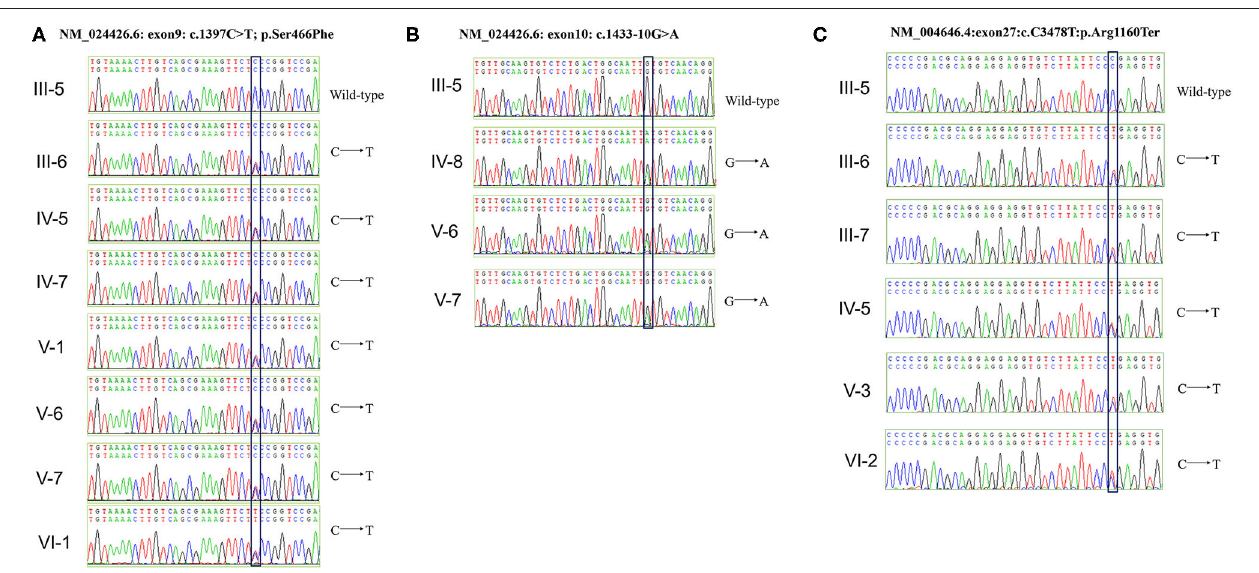
FIGURE 3 | Verification of WT1 and NPHS1 variants by Sanger sequencing. (A) The c.1397C > T; p.Ser466Phe mutation was verified in seven family members (III-6, IV-5, IV-7, IV-8, V-1, V-6, V-7, and VI-1). (B) The c.1433-10G > A mutation was verified in three family members (IV-8, V-6, and V-7). (C) The c.3478C > T; p.Arg1160Ter mutation was verified in five family members (III-6, III-7, IV-5, V-3, and VI-2).